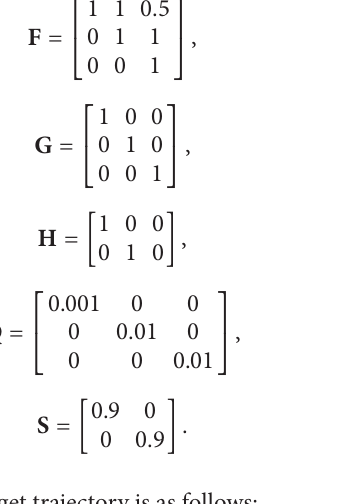
Figure 2: Estimation of the intelligent target by the minimax filter with fixed